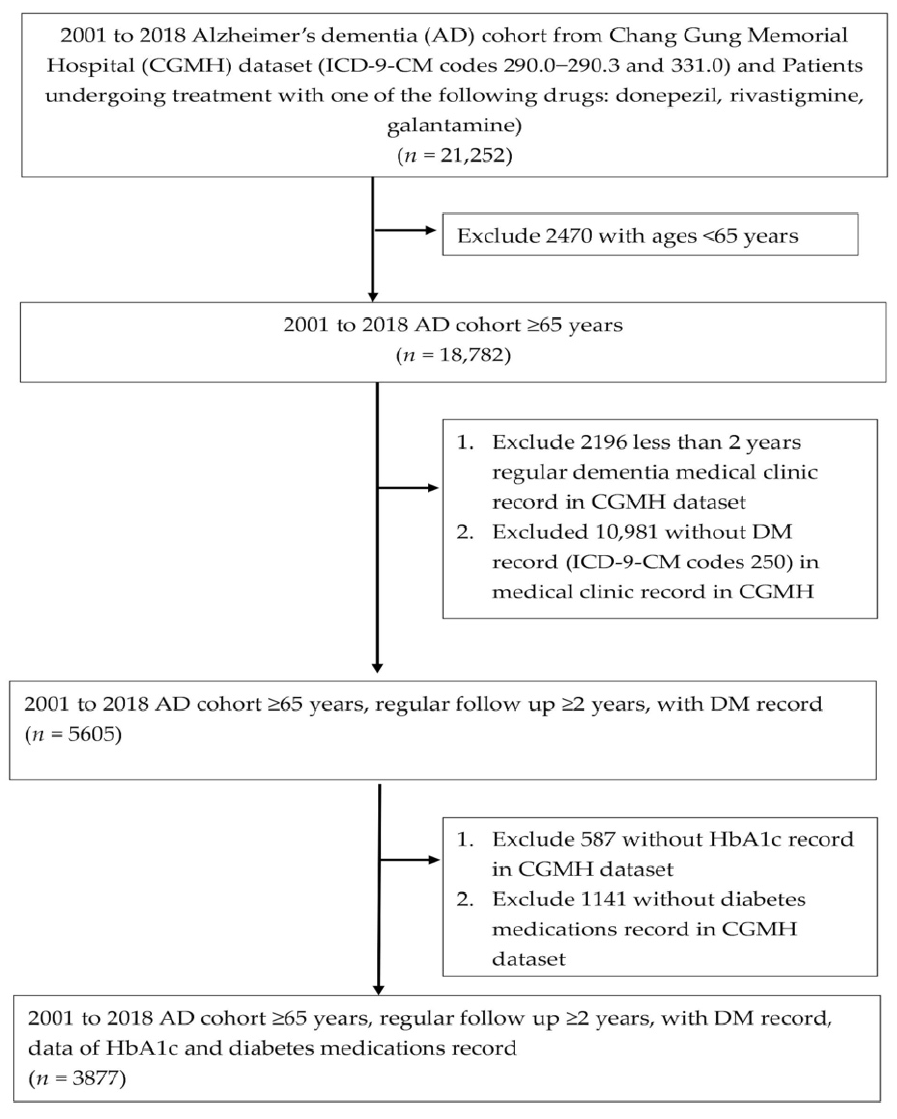
Figure 1. Study process flow chart. ICD-9-CM, International Class of Disease, Ninth Revision, Clinical Modification. Table 1. Patient characteristics for all patients with Alzheimer’s dementia and type 2